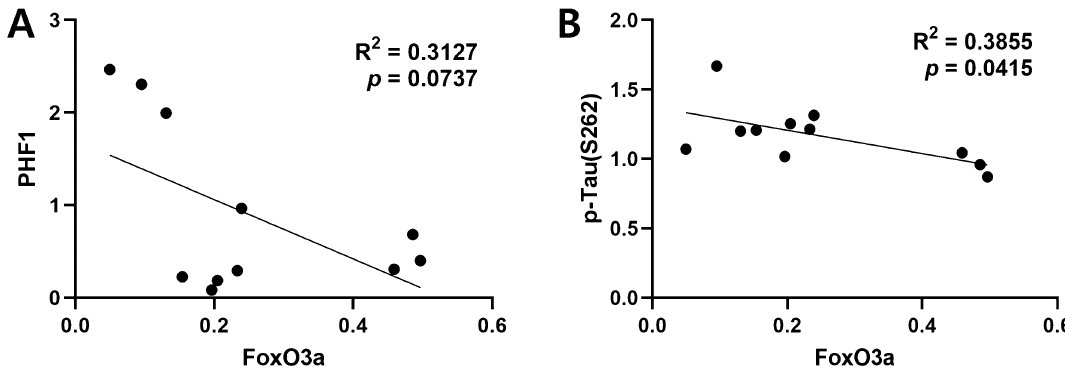
Figure 5. Protein levels of phosphorylated tau were negatively correlated with those of FoxO3a. ( A ) The correlation of protein levels between FoxO3a and tau phosphorylated at S396/404 (PHF1) was analyzed with the Pearson’s correlation test (E4 carriers n = 4, non-carriers n = 7). ( B ) The correlation of protein levels between FoxO3a and tau phosphorylated at S262 protein levels was analyzed with the Pearson’s correlation test (E4 carriers n = 4, non-carriers n = 7). Linear regressions are shown as solid lines.